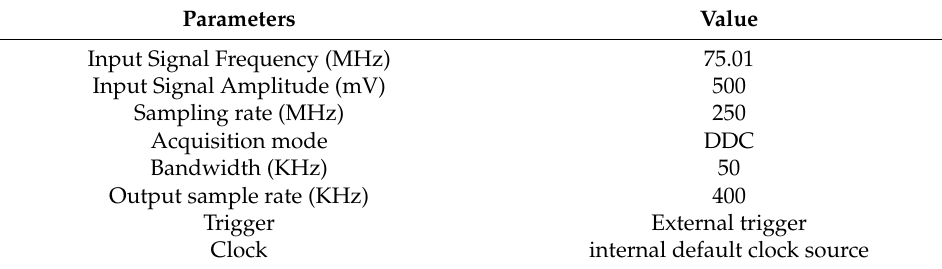
Figure 12. The Flow chart of acquisition card. Table 3. Test parameters of